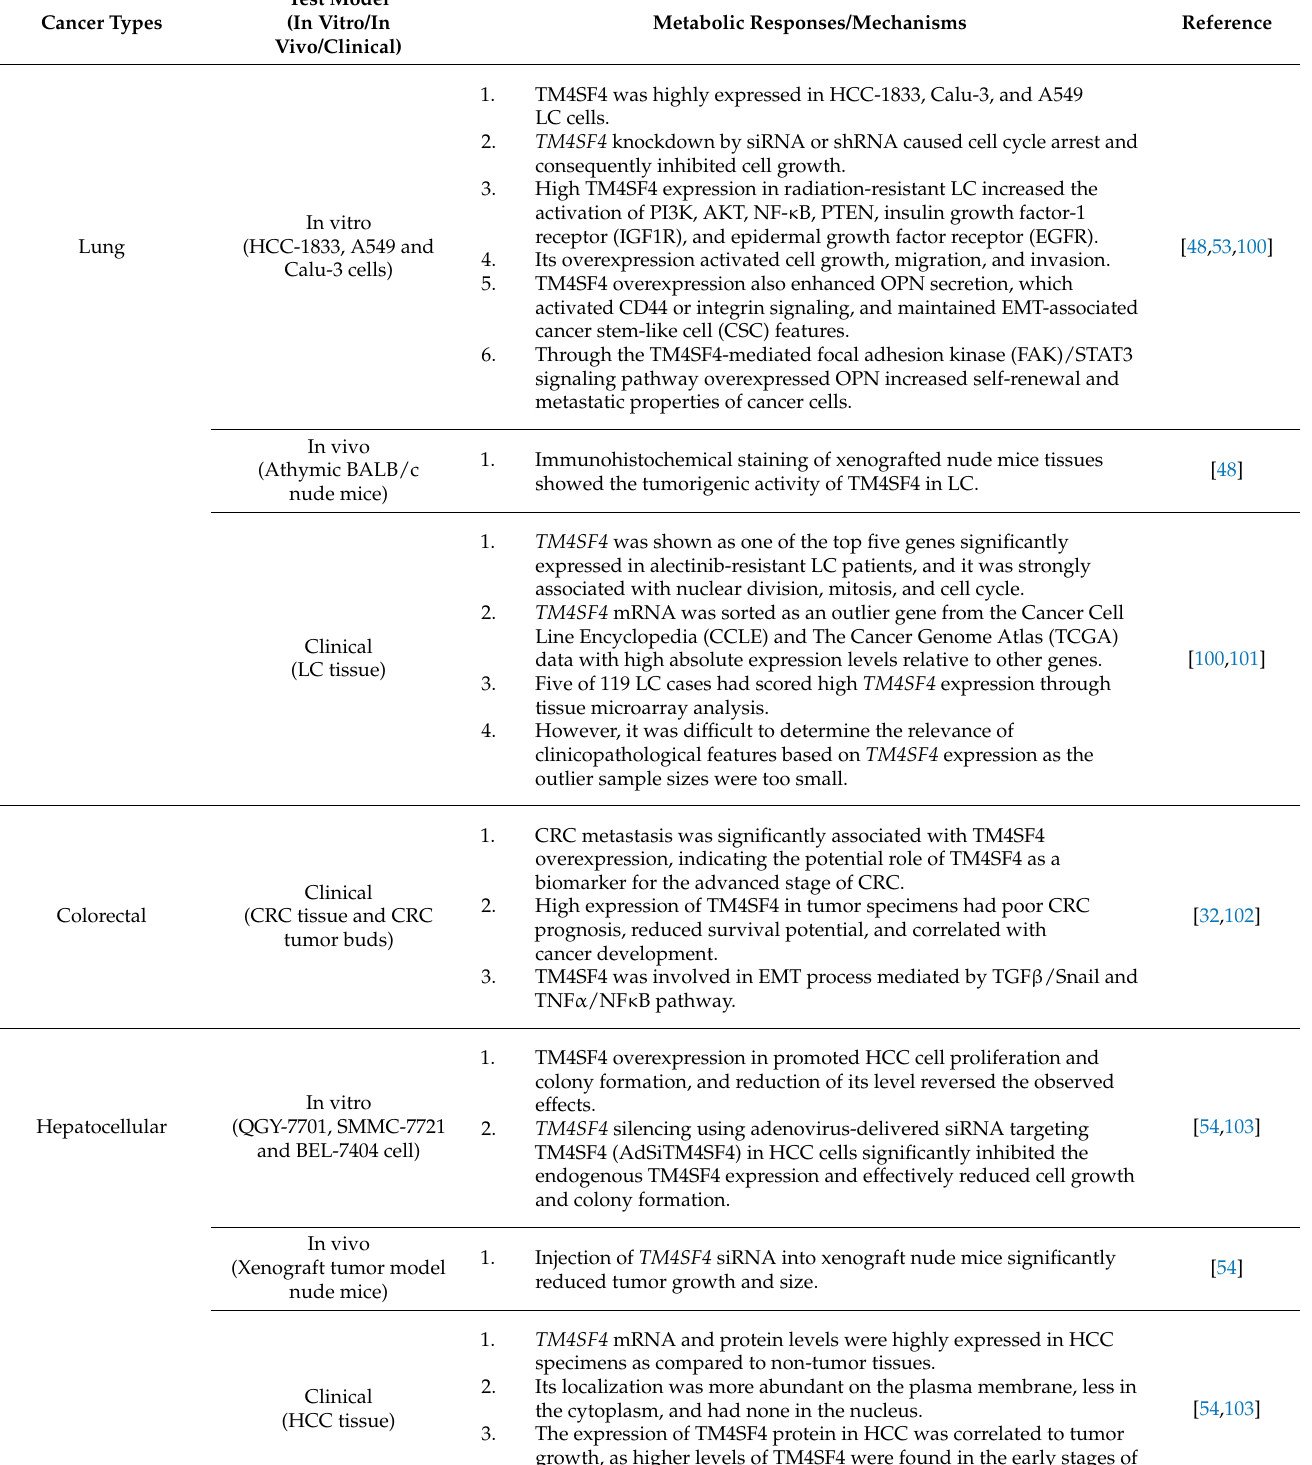
Table 2. Molecular expression, regulatory roles, biomolecular interactions, and the underlying mechanism of actions of TM4SF4 against cancer phenotypes and